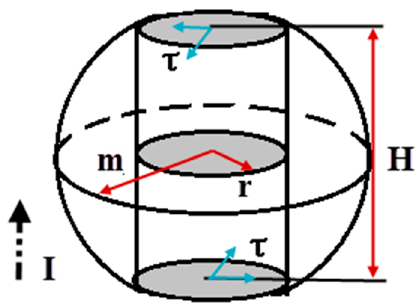
Figure 3. Schematic diagram of BGA solder joint and equivalent crack.